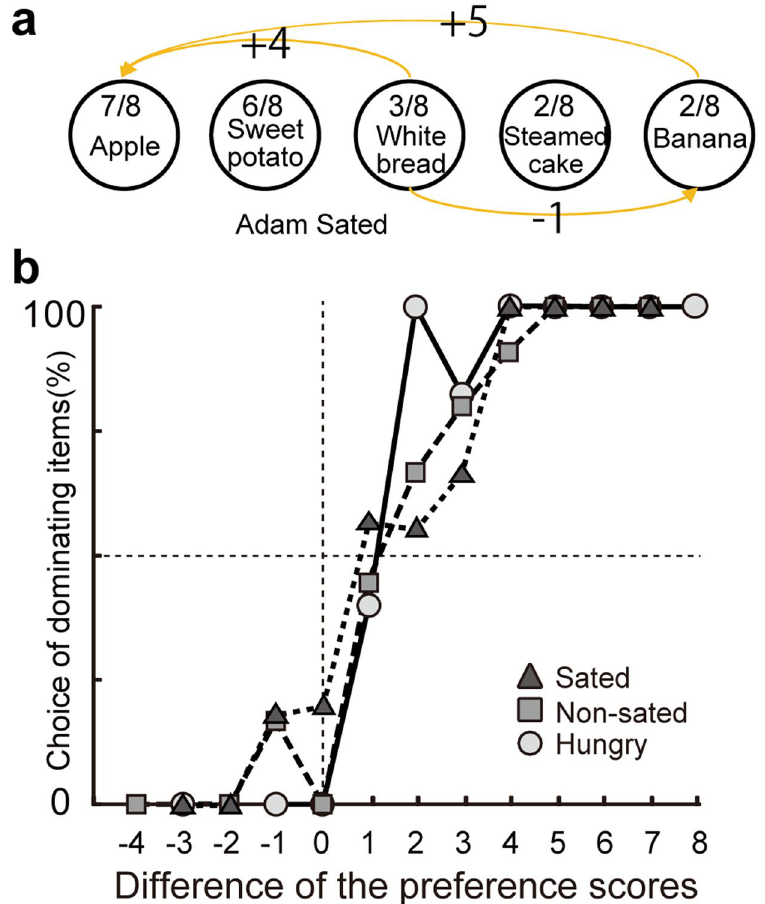
Figure 4. Effect of hunger states on the choice of dominating food items. ( a ) Three example choices of the dominating items as a function of the difference of preference scores in monkey Ada in the sated condition. Values on the yellow arrows indicate differences in the preference score between two items. ( b ) Percent choices of the dominating items as a function of the difference of preference scores in each of the three food access conditions. Data of all animals were aggregated in each of the three food access